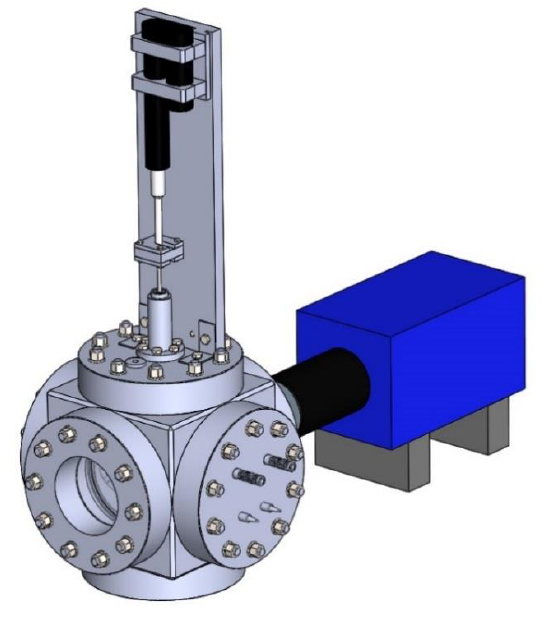
Fig. 7. 3D model of the drop test rig with the camera